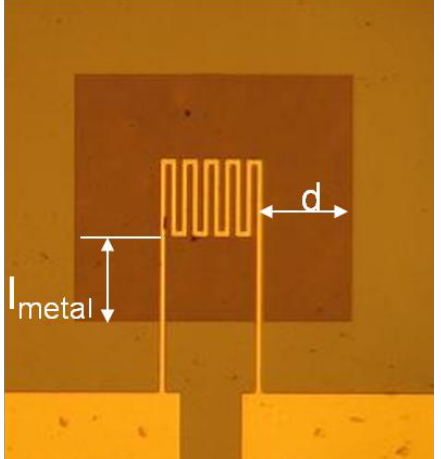
Figure 2. Optical micrograph of the top view of a 1,040 µm square silicon nitride membrane Pirani gauge with d the distance between the hot and cold region and l length of the metal line connecting the hot to the cold